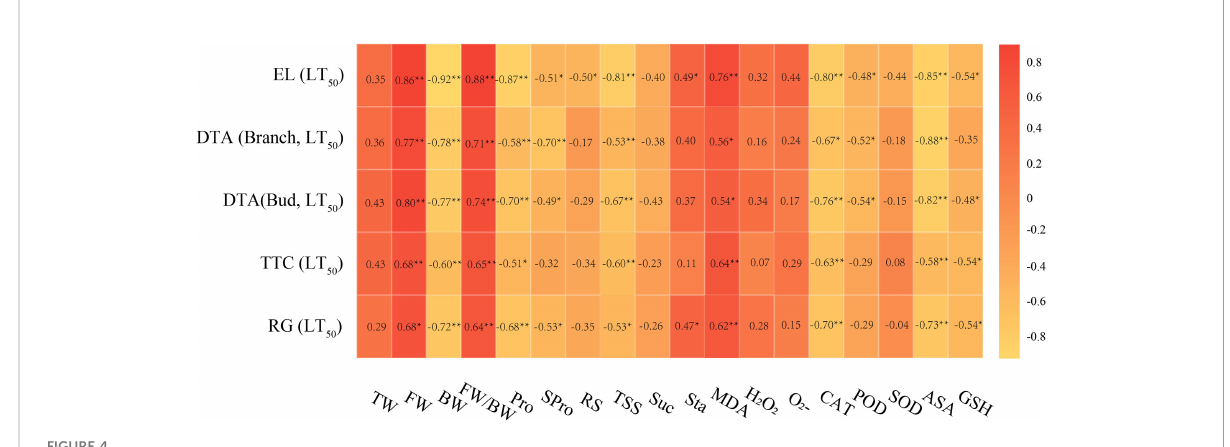
FIGURE 4 Correlation analysis of LT 50 values and cold resistance indicators. Data were tested by Student ’ s t-test, ** p < 0.01 represent signi fi cant differences between LT 50 values measured by different evaluation methods and different cold resistance